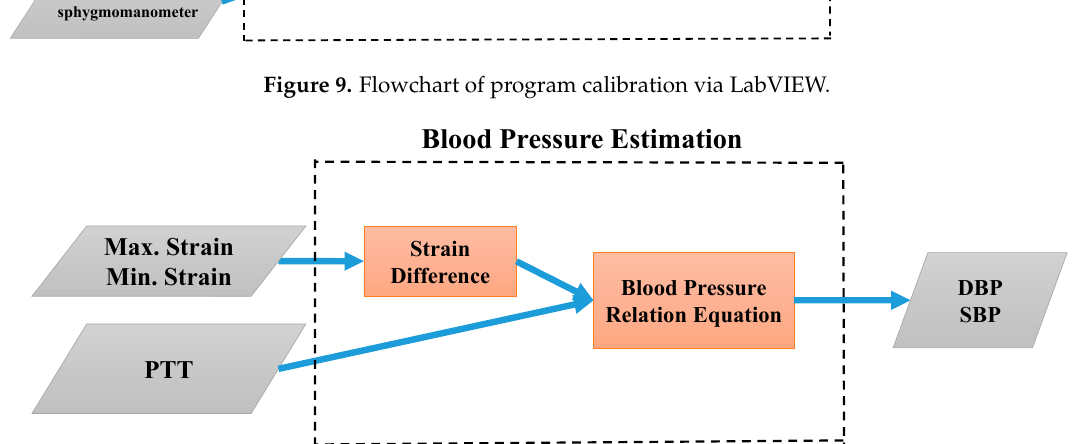
Figure 9. Flowchart of program calibration via LabVIEW.